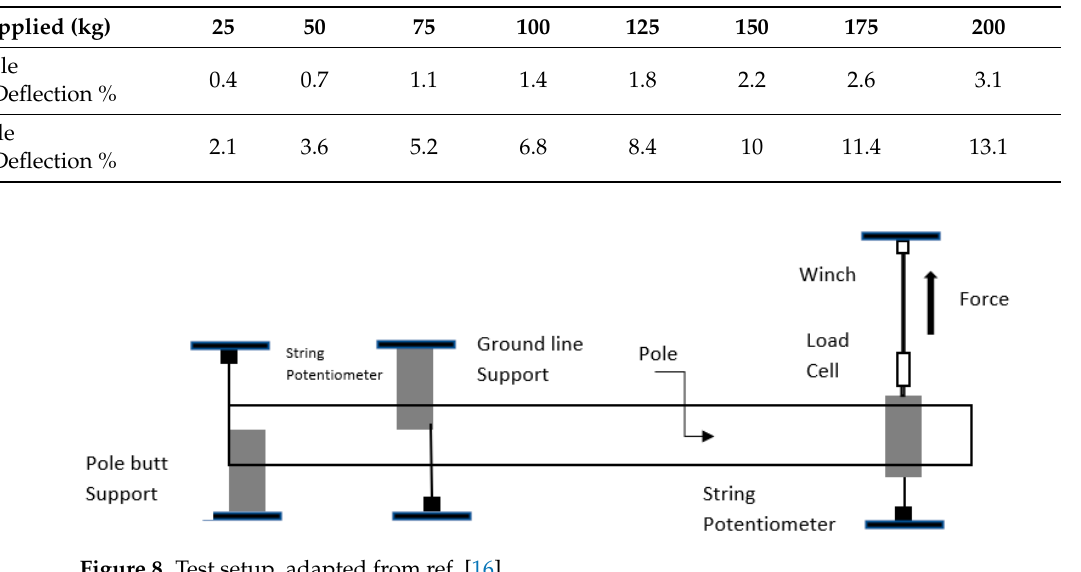
Figure 8. Test setup, adapted from Ref.